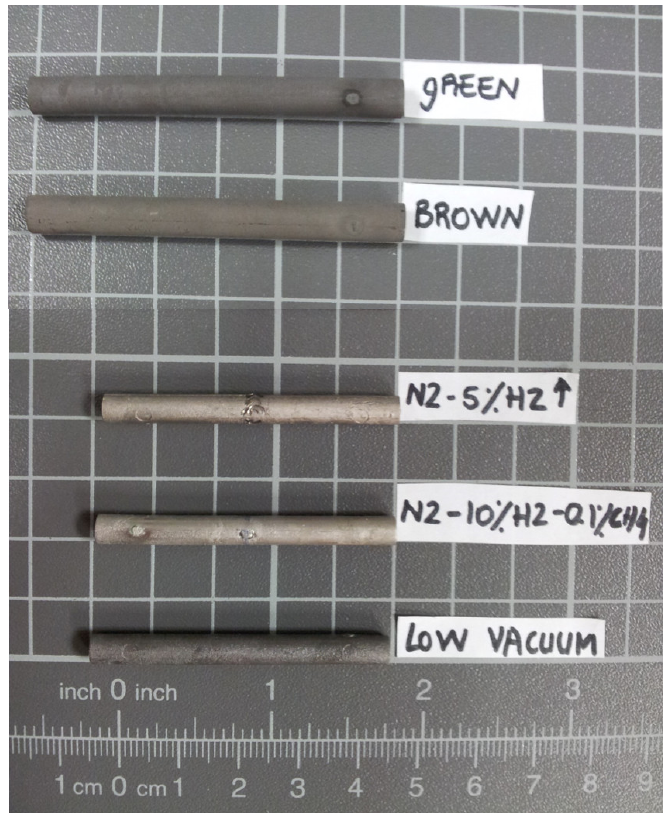
Figure 13. Images of the geometry samples after each processing step (green state, brown state and sintering state under different